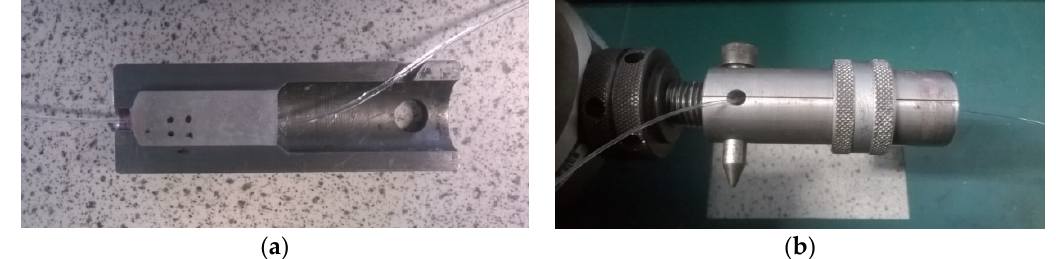
Figure 3. Collet in use for forming epoxy plug ( a ) and in the tensile test machine ( b ) .